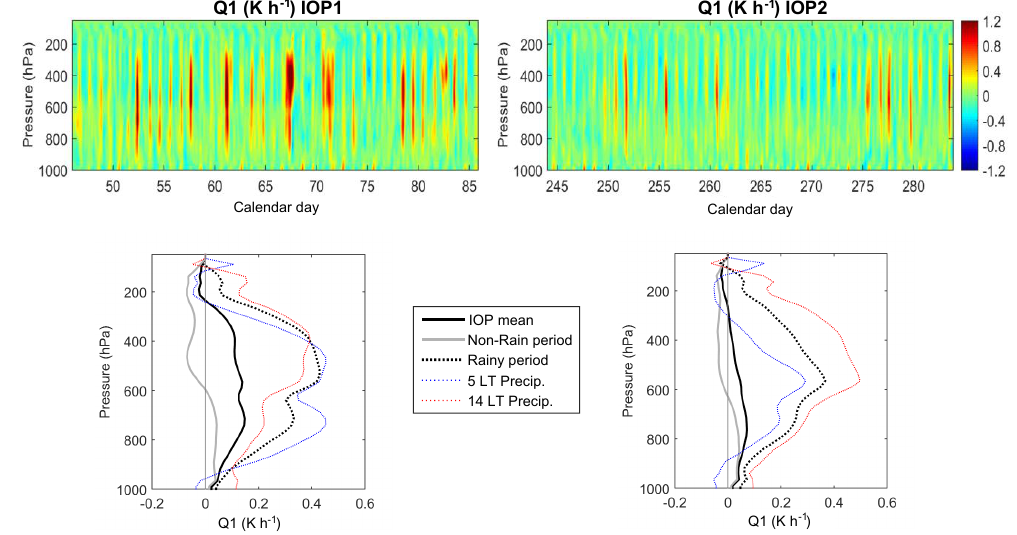
Figure 5. The time series (top) and temporal mean profiles (bottom) of apparent heating source Q 1 for IOP1 (left) and IOP2 (right).